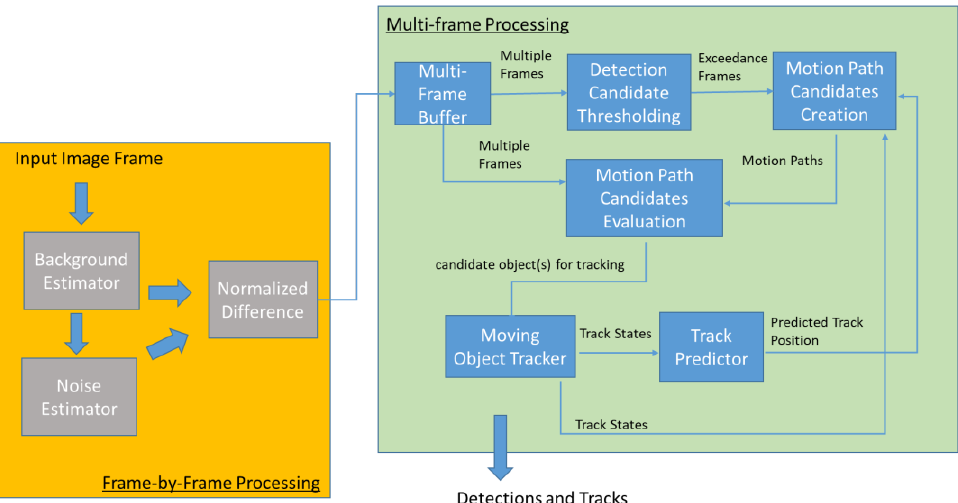
Figure 3. Multi-frame Moving Object Detection System.